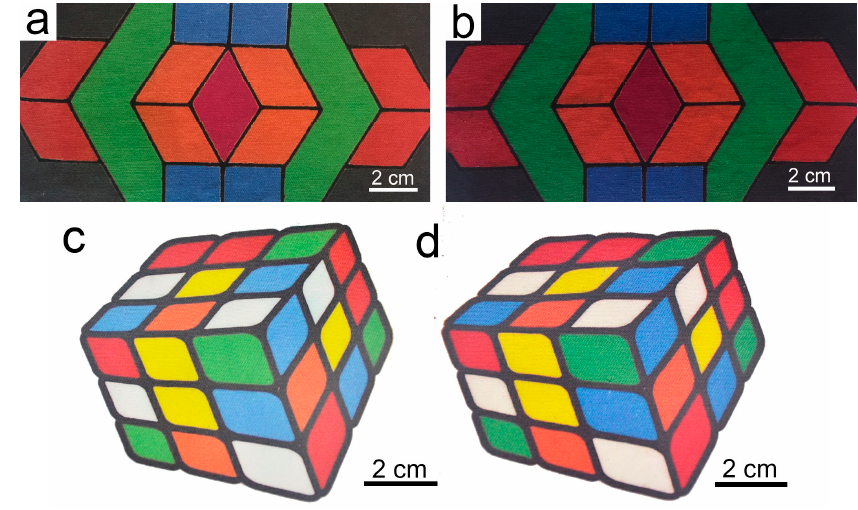
Figure 9. Colorful pictures of ink-jet printing on uncationized ( a , c ) and cationized cotton ( b , d ).